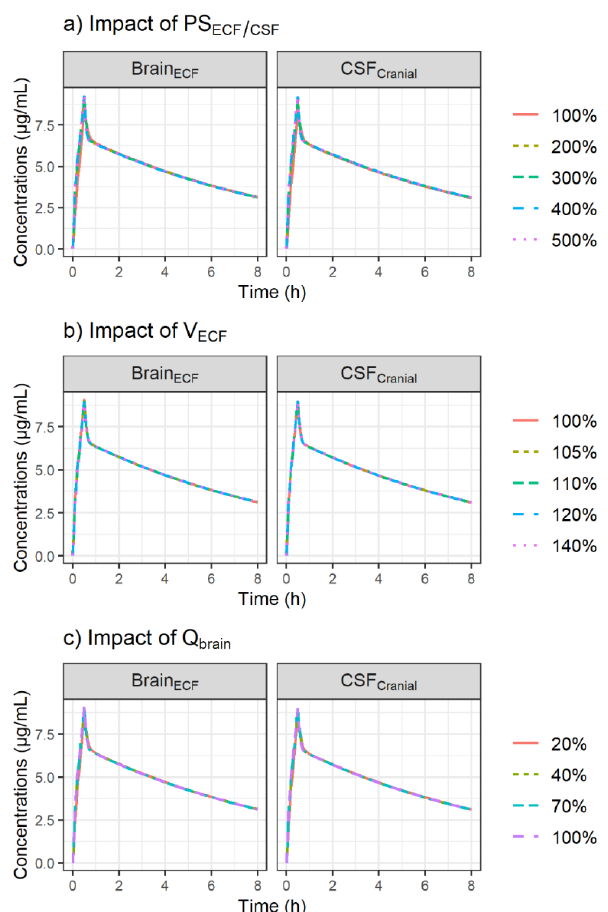
Figure 3. Simulation of the impact of increased passive diffusion clearances, PS ECF/CSF ( a ), increased brain ECF volume, V ECF ( b ) and reduced cerebral blood flow, Q brain ( c ) on CNS PK profiles of metronidazole after administration of a single dose of 500 mg using the minimal PBPK model. The plots were stratified by CNS compartment (panels).